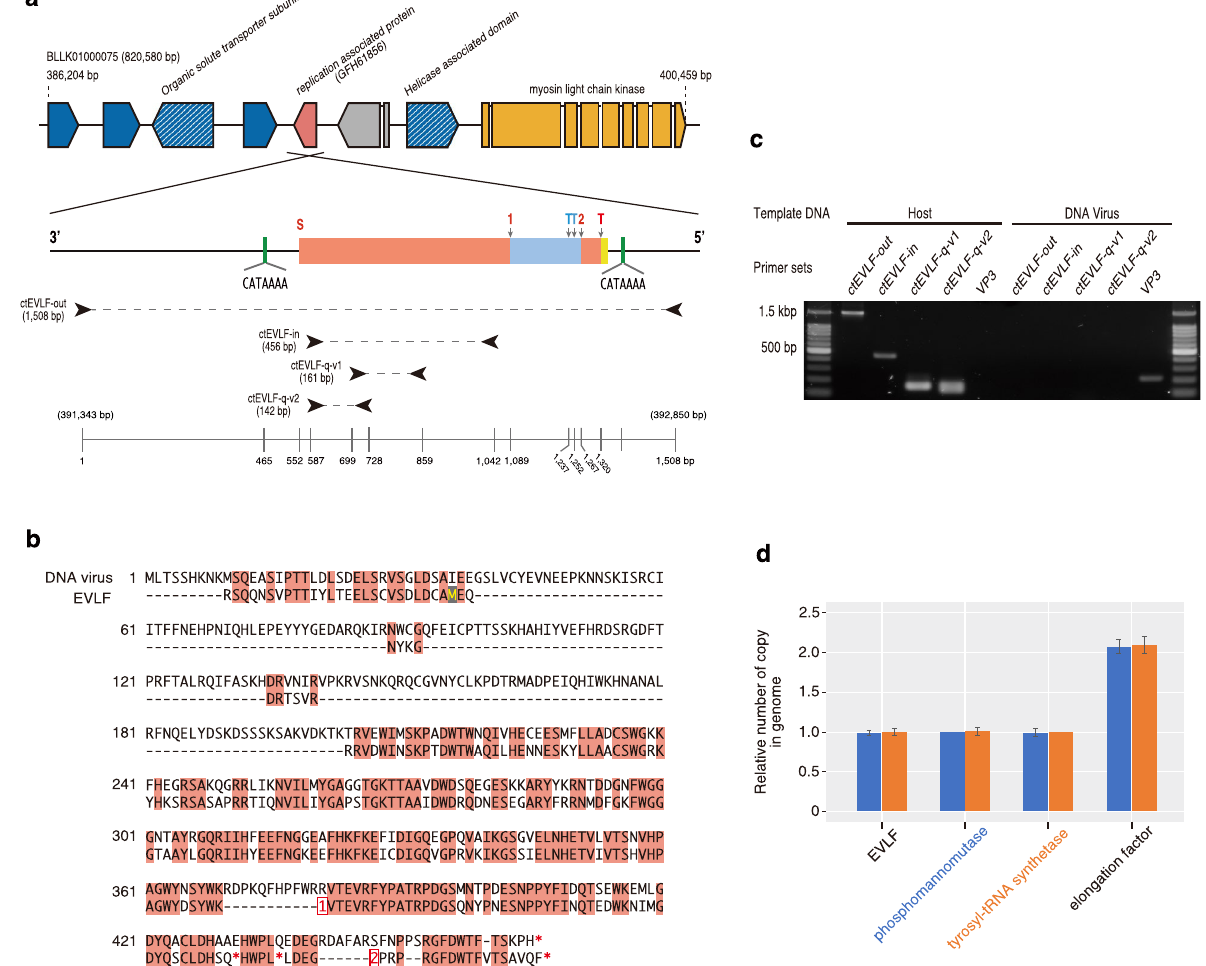
Figure 1. ( a ) Location and structure of the EVLF in the host genome. Gene directions are indicated by wide arrowheads at the end of each coding sequence. Blue and hatched blue indicate genes coding hypothetical proteins and hypothetical proteins possessing known domains, respectively. Orange indicates a myosin light chain kinase, and pink indicates a virus-like fragment. The structure of the EVLF sequence encoded on the reverse DNA strand is shown as a close-up. The pink and blue boxes indicate first and third open reading frames, respectively, due to single and double nucleotides were inserted in the positions marking on the boxes as “1” and “2”, and the “S” and “T” on the boxes refer to the start and terminal codons, respectively. A yellow box indicates a poly-(A) like sequence, and green boxes indicate a “CAT AAA A” sequence. Black arrowheads indicate the amplification primer sets, ctEVLF-out-v1, ctEVLF-in-v1, ctEVLF-q-v1, and ctEVLF-q-v2, which amplified the 1508 bp, 456 bp, 161 bp, and 142 bp PCR products, respectively. ( b ) Alignment of amino acid sequences between the EVLF of C. tenuissimus NIES-3715 and a replication-associated protein in its infectious DNA virus. The alignment was constructed by MAFFT 63 . Pink boxes indicate consensus amino acid residues. Hyphens, asterisks, numbers in red boxes indicate gaps, termination codons, and nucleotide insertions, respectively. ( c ) PCR amplification for four primer sets using C. tenuissimus NIES-3715 and DNA virus. The amplification length of ctEVLF primer series is indicated ( a ) and that of VP3, which is coded in DNA virus genome, is 212 bp. No PCR bands using ctEVLF primer series were detected in DNA virus. ( d ) The relative number of gene copy in the C. tenuissimus NIES-3715 genome. The gene copies were relativized by phosphomannomutase (blue bar) or tyrosyl-RNA synthetase (orange